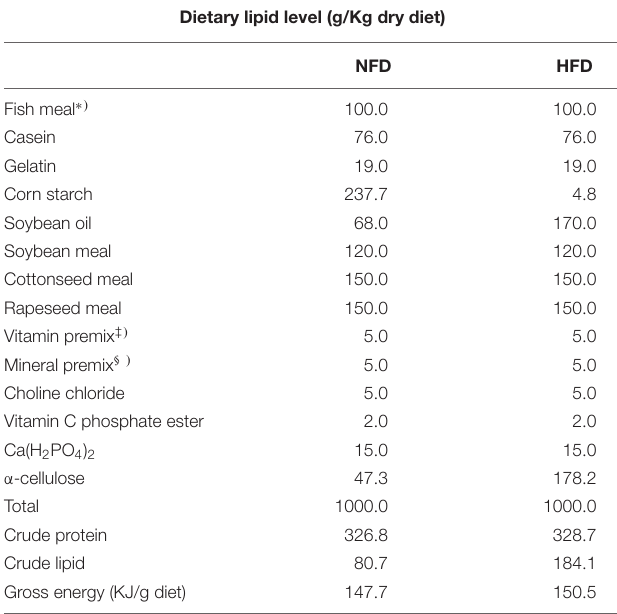
TABLE 1 | Ingredients and composition of normal-fat diet (NFD) and high-fat diet (HFD). Dietary lipid level (g/Kg dry